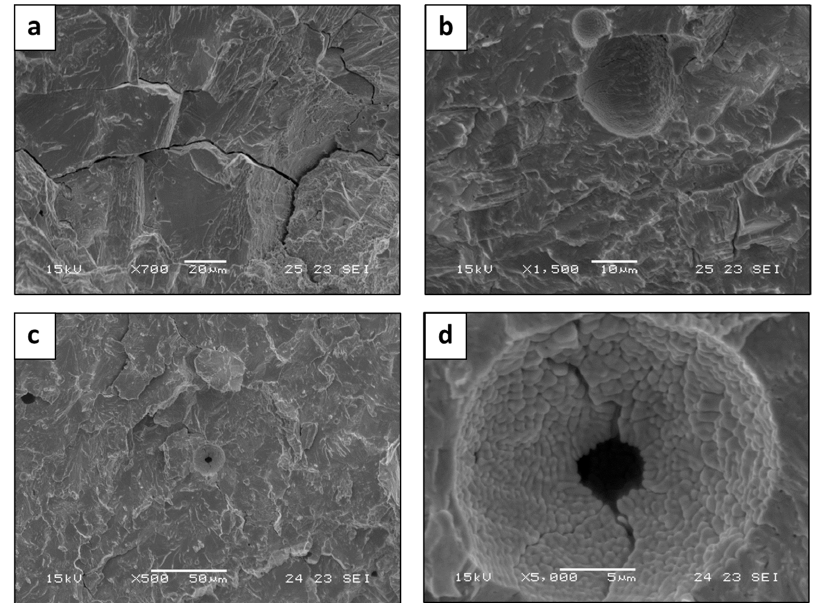
Figure 9. Fractography analysis of HEA WTaMoNbV produced by LPBF process: ( a , b ) trans-granular fracture, ( c , d ) fracture surface with typical LPBF defects.